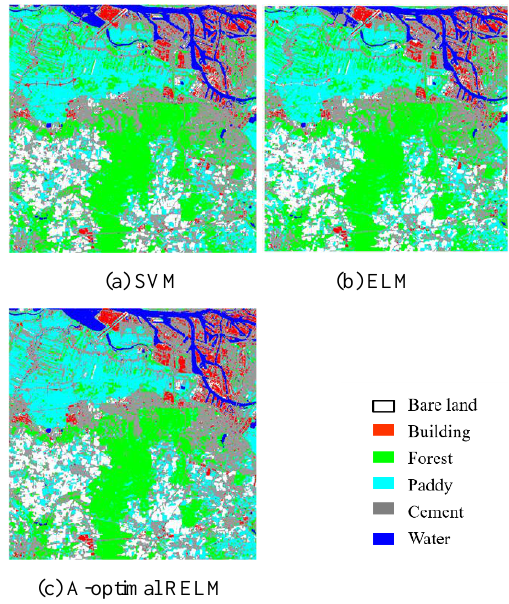
Figure 4. classification results based on Hamburg image